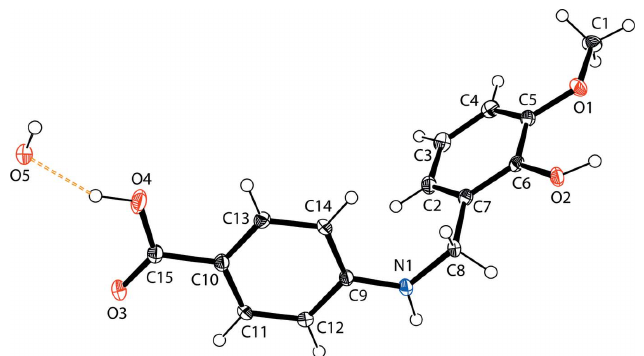
Figure 1 The molecular structure of the title compound, showing the atom labelling. The intermolecular O—H (cid:2)(cid:2)(cid:2) O hydrogen bond involving the water molecule is shown as a dashed line (see Table 1 for details). Displacement ellipsoids are drawn at the 40% probability level.